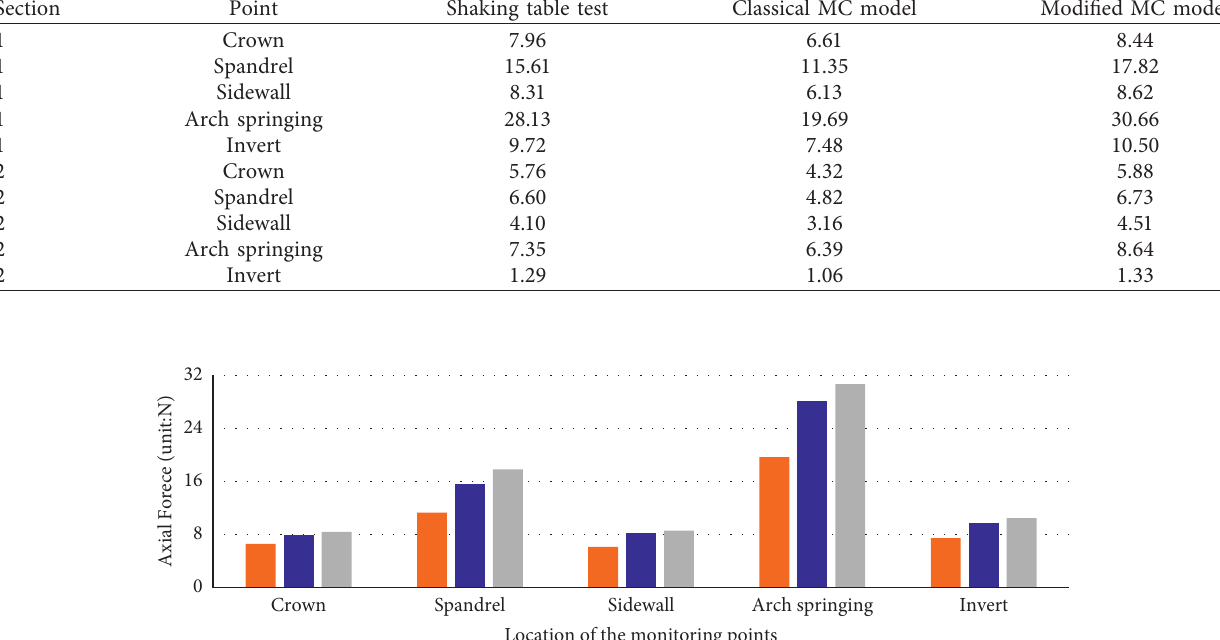
Table 10: Maximum axial forces at the monitoring points for the different yield criterion models (unit: N). Section